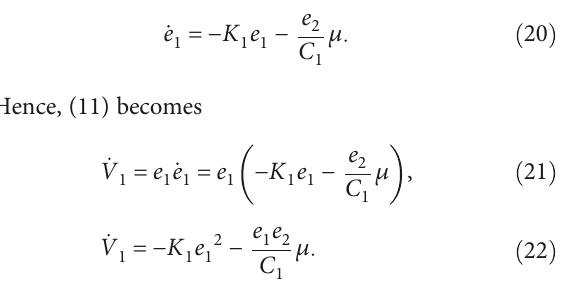
Table 1: Parameters of PV array.